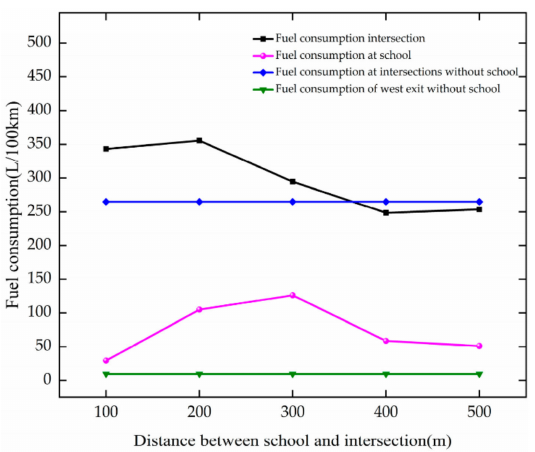
Figure 24. Variation trend of fuel consumption with